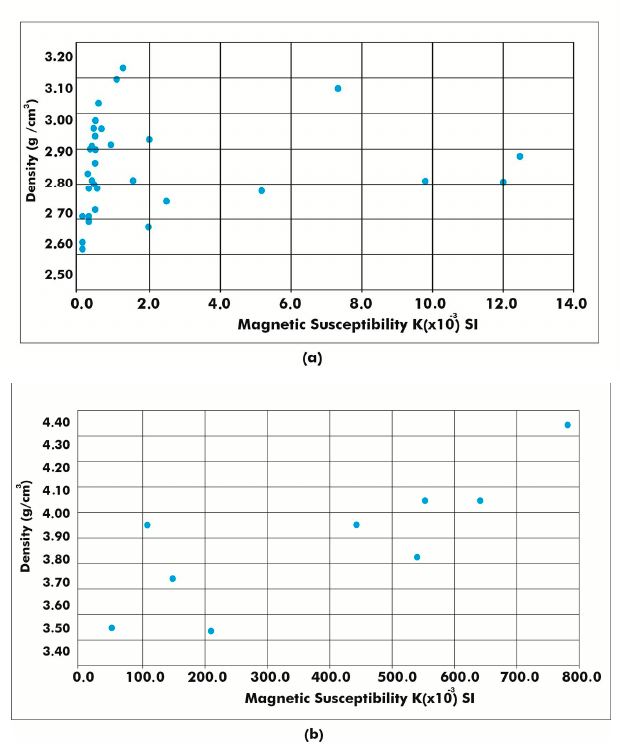
Figure 7. ( a ) Thirty-three samples measured for density and susceptibility taken from exploration drill holes in the Riacho do Pontal copper district, ( b ) 11 samples measured for density and susceptibility from rock samples collected from the outcrops and mines of Vale do Curaça copper district.